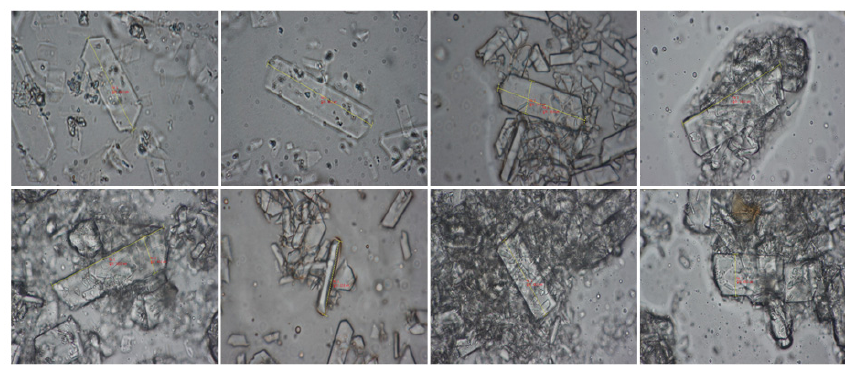
Figure 7. SEM picture of recovered material.